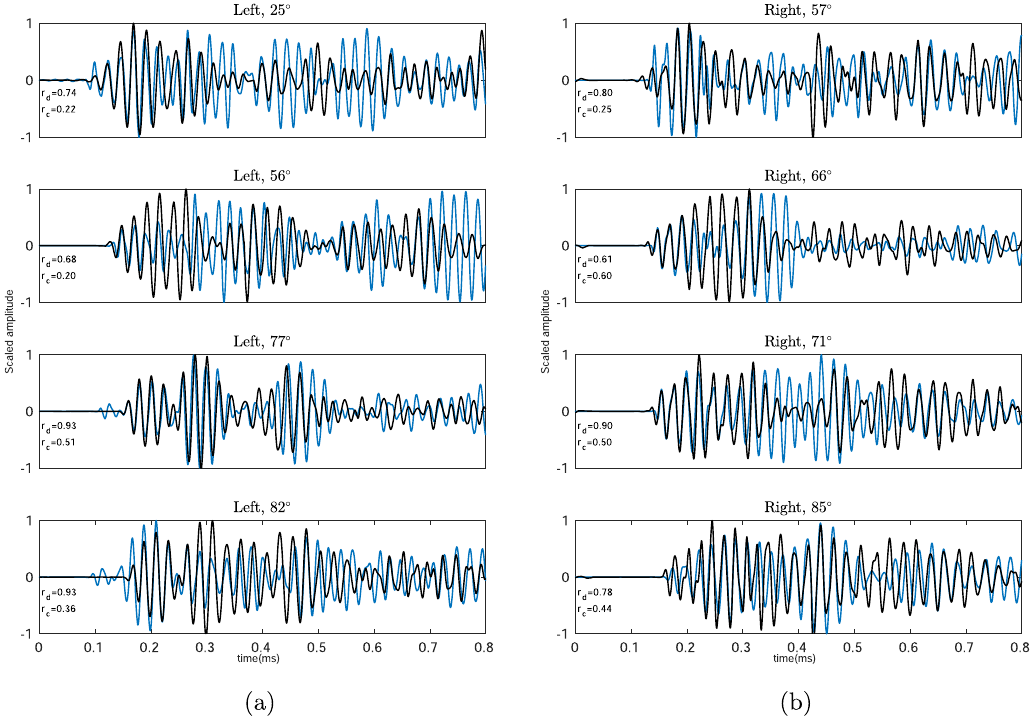
Figure B.1. Comparison between experimental data (black) and simulated data (blue) for different angles at (a) left and (b) right receivers. The correlation coef fi cients between the two signals for both the direct ( r d ) and coda ( r c ) parts of the signals are indicated in the bottom left of each